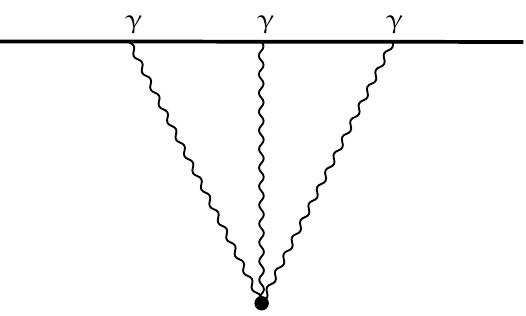
Figure 1 . Cubic contact